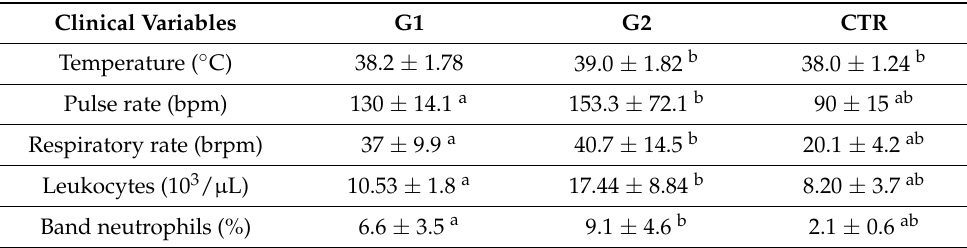
Table 4. Mean and standard deviation of clinical variables in dogs with a favorable (G1) and poor (G2) prognosis and CTR.